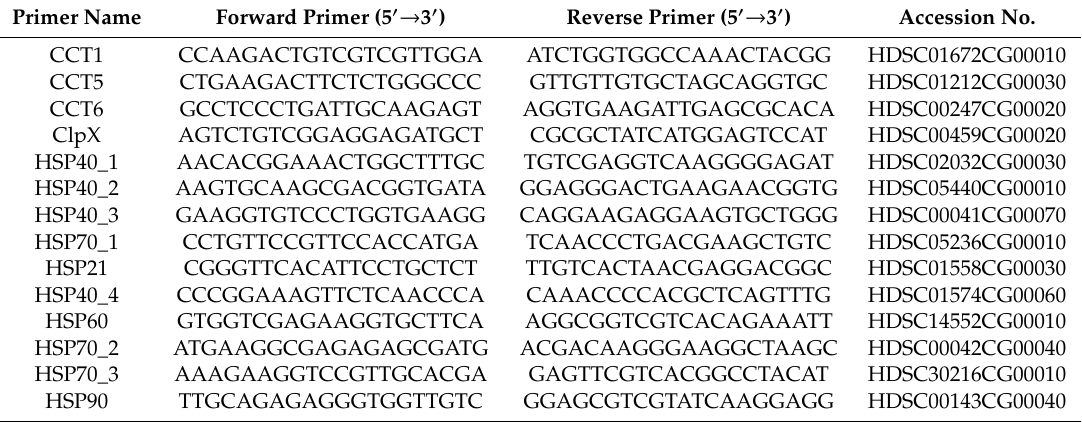
Table 1. Primer sets for genes analyzed by